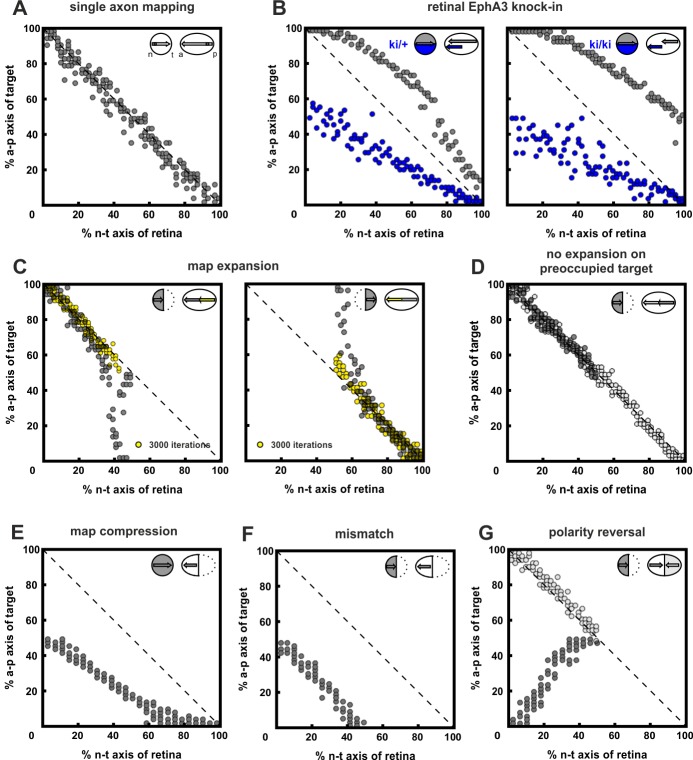
Inclusion of co-adaptation does not alter the explanatory power of the computational model.For purposes of comparison, this figure, produced using the updated model that includes co-adaptation presented in this paper is structured in parallel to figure 7 in Gebhardt et al. (2012), which did not take adaptation into account. The results are highly similar, demonstrating that the inclusion of co-adaptation does not alter the performance of the original model. (A) 200 simulations of single fibers chosen randomly from the retinal field. Consistent with the experimental evidence in zebrafish, single fibers map topographically, as indicated by the accumulation of terminals on the main diagonal of the mapping plot. (B) EphA3 knock-in, Rki, in every second fiber (blue; ki/+: Rki = 2; ki/ki: Rki = 4; axonal ligand on knock-in fibers was reduced reciprocally to the axonal receptor). Consistent with the experiment, wild-type fibers (gray) are posteriorly displaced, with a more severe effect in homozygotes. (C) Map expansion. 100 fibers chosen from the nasal (n) or temporal (t) half of the retina reach their correct target (yellow) after 3000 iterations. After 30,000 iterations, fibers stably cover the whole tectum (gray). (D) No expansion occurs (gray) when a n half retina grows into a field containing the remnants of a previous full innervation (white). (E) Map compression. 200 fibers from a whole retina form a compressed topographic projection when growing into an anterior tectum half. (F) Mismatch. 100 n fibers form a half-projection, when growing into an anterior, non-matching, tectal half. (G) An additional n projection (gray) displays polarity reversal when growing into a tectal field still containing properly mapped n fibers (white) (n = 100; fiber–fiber interactions were put into effect earlier than usual, i.e., j = 2000 in C(i)).